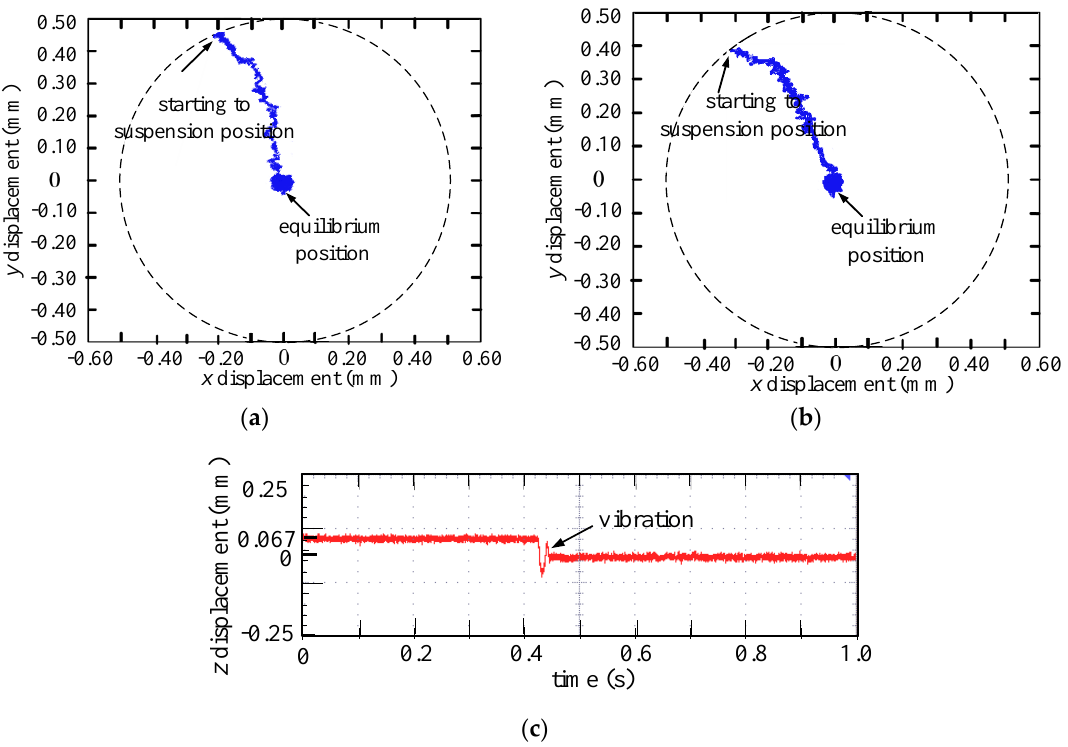
Figure 10. Trajectories and displacement waves of the rotor adopting “full prediction model” at the start-of=suspension state. ( a ) Mass center orbit of the rotor under the support of the AC 2-DOF HMB; ( b ) Mass center orbit of the rotor under the support of the AC–DC 3-DOF HMB; ( c ) Displacement waveforms of the rotor under the support of the AC–DC 3-DOF HMB.